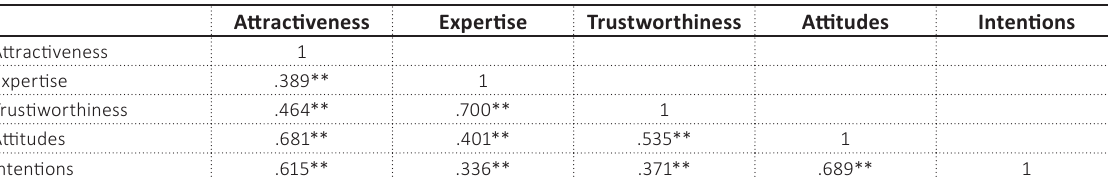
Table 4. Correlation